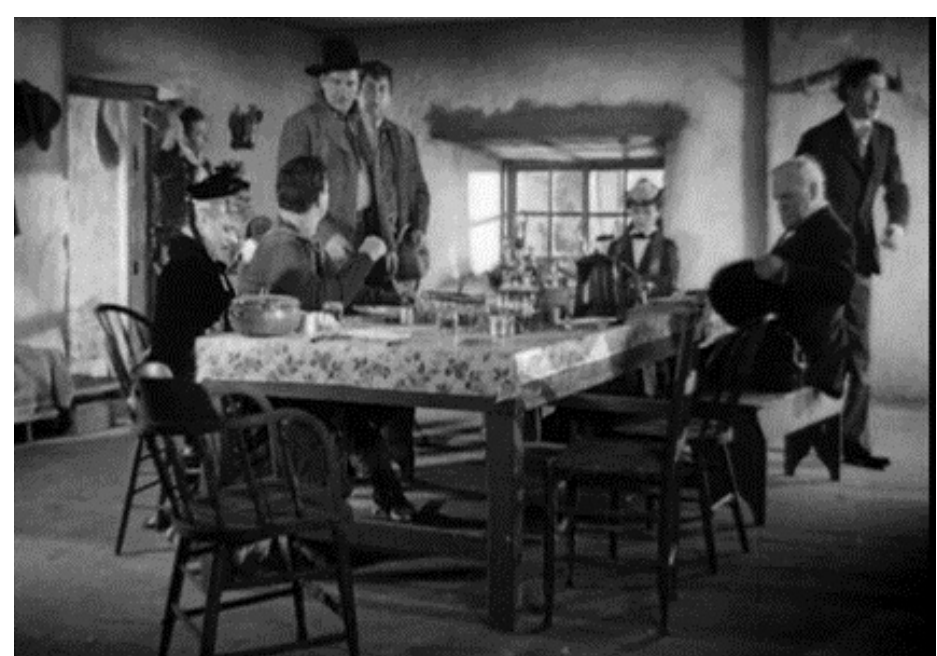
Figure 6: The table scene after Lucy Mallory moves from one end to the other to avoid Dallas. Ringo and Dallas are now isolated from the group, separating the proper members of society from its outcasts. Lucy Mallory has her gaze at eye level, dominating the table from its head. Dallas has her gaze downward in submission and humiliation. Ringo is